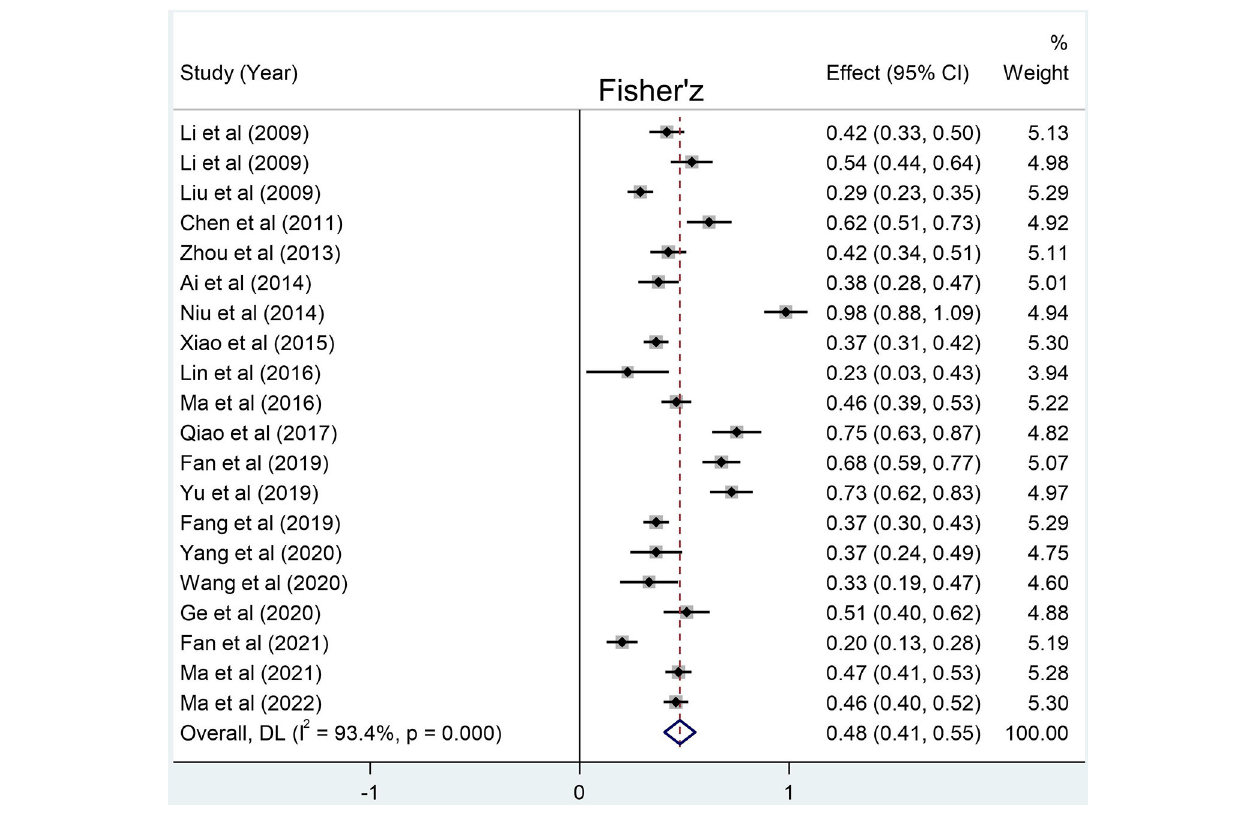
FIGURE 4 | Forest plots for the correlation between social support and resilience. Weights are from random-effects model.